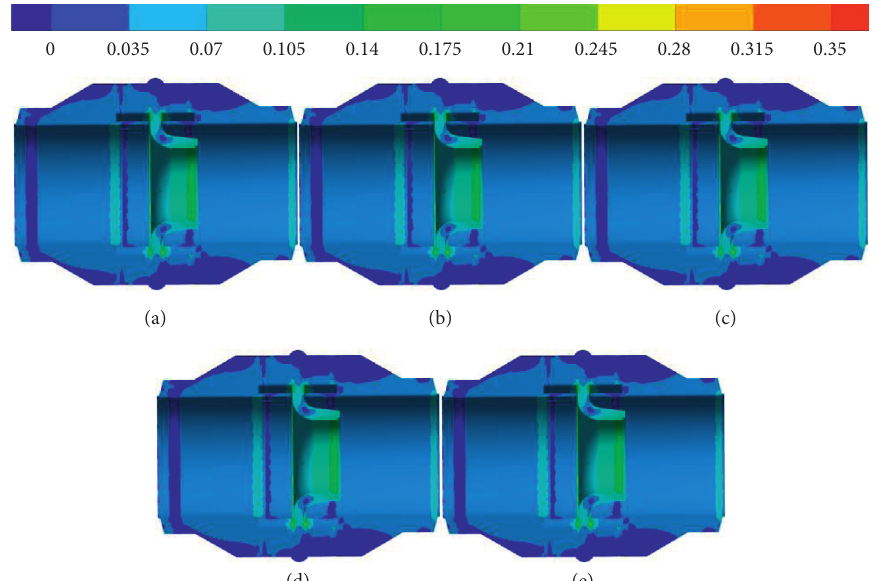
Figure 15: Dynamic stress distribution of cross section in flow meters (10 m 3 /h). (a) 50 ° C. (b) 100 ° C. (c) 300 ° C. (d) 500 ° C. (e) 700 ° C.